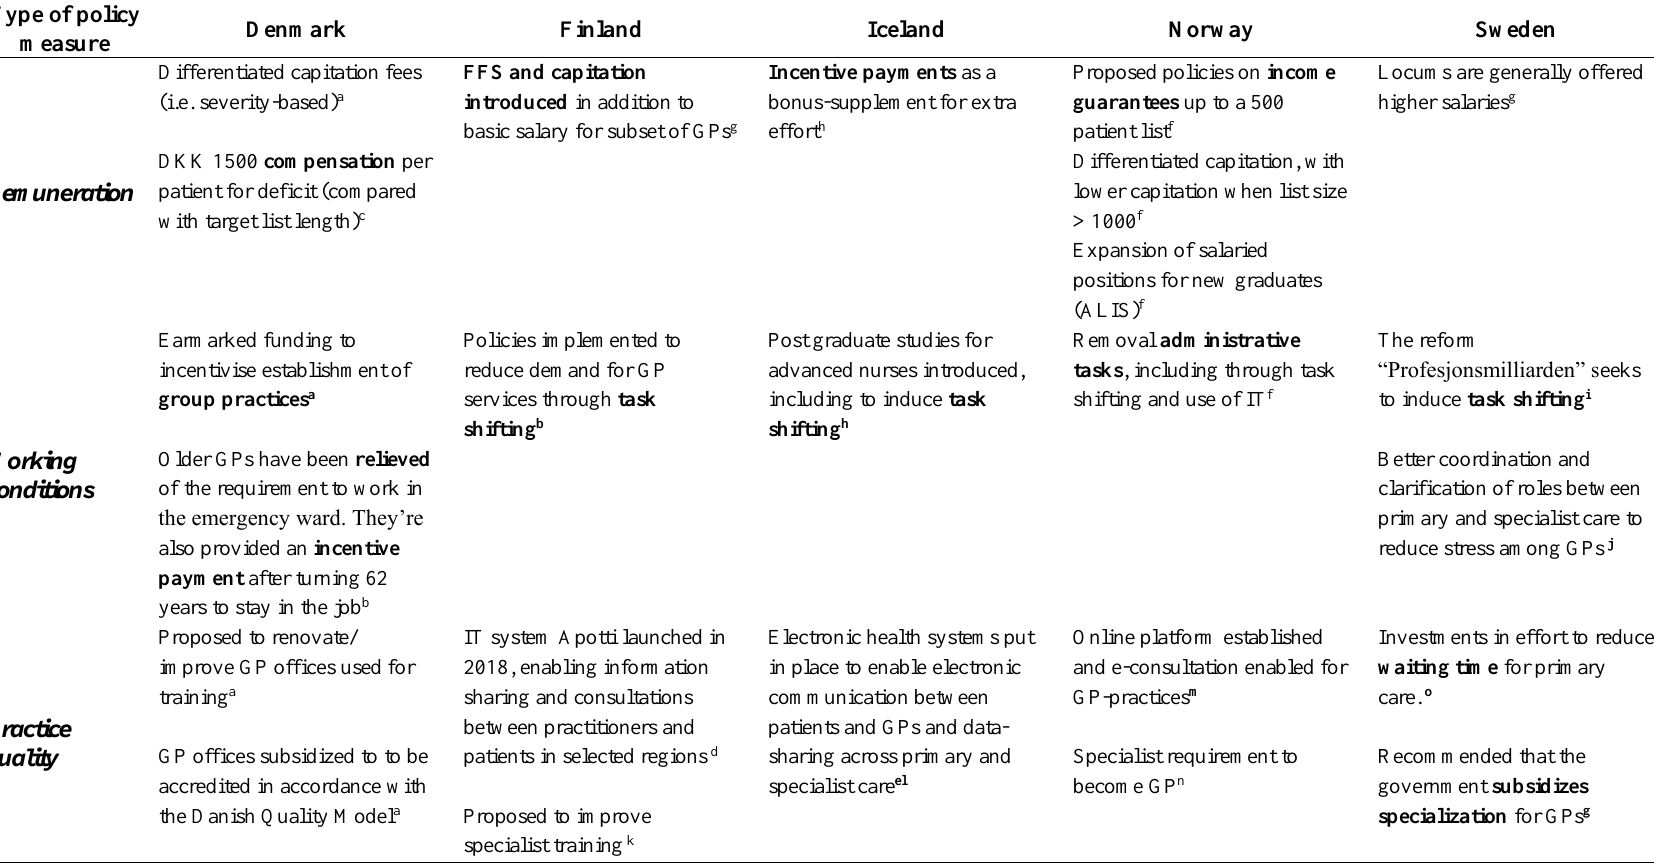
Table 1: Overview of selected reforms and policy measures, 2010-2020 Type of policy